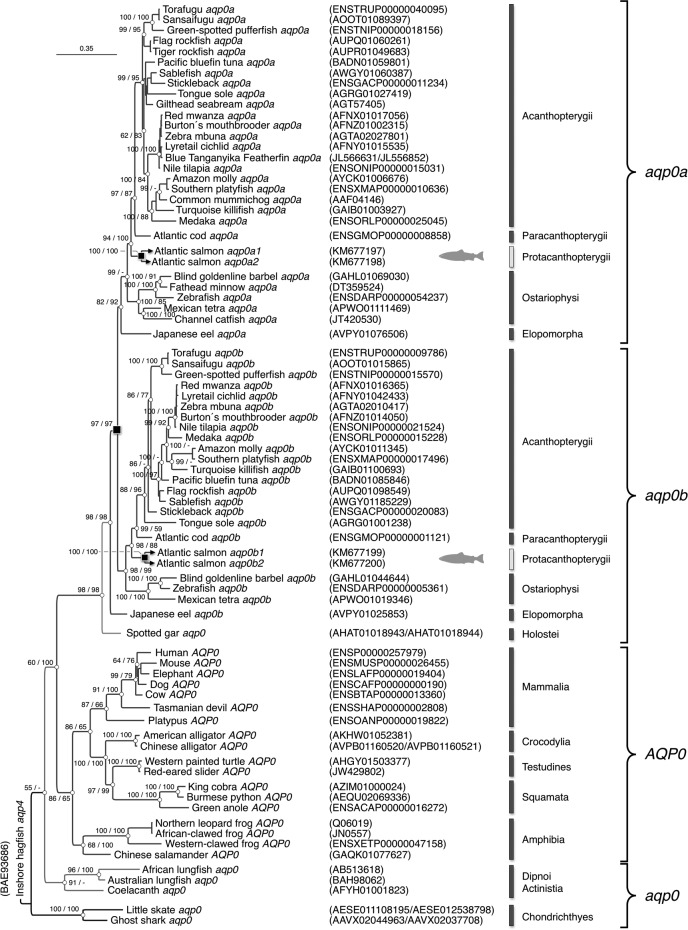
Phylogenetic relationships of Aqp0 in Gnathostomata. Bayesian majority rule consensus tree of a codon alignment of vertebrate aqp0 orthologs resulting from 5 million Markov chain Monte Carlo generations and a burn-in of 25%. Posterior probabilities of the codon/amino acid analyses are shown at each node, where - indicates <50%. The tree is rooted with Inshore hagfish (Eptatretus burgeri) aqp4, with the scale bar indicating the rate of nucleotide substitution per site. Whole genome duplication events are shown as black squares at the relevant nodes.